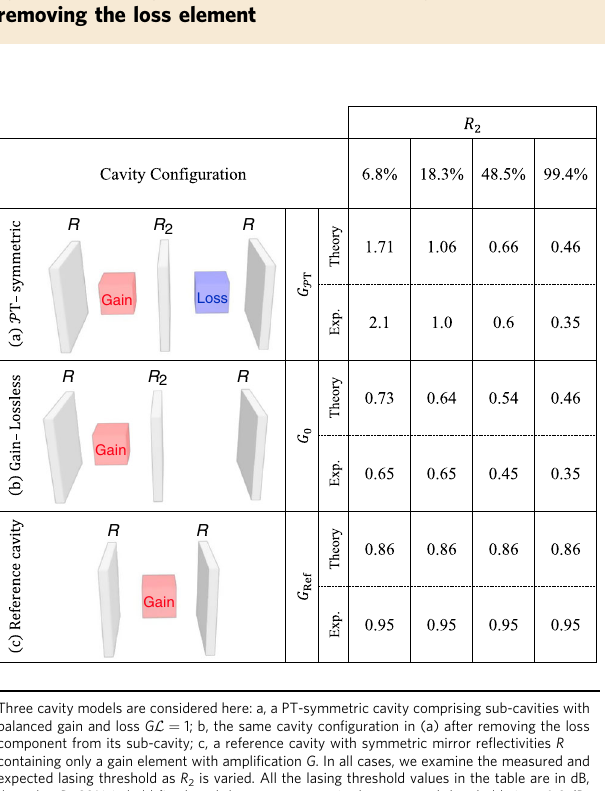
the left in b using single-mode optical fi bres. Specially designed FBGs are used as partially re fl ecting mirrors with re fl ectivies R , R 2 , and R from left to right. Gain is provided by a SOA and attenuation by a VOA. d , Optical setup in c after inserting an additional 1-km-long fi bre spool. A